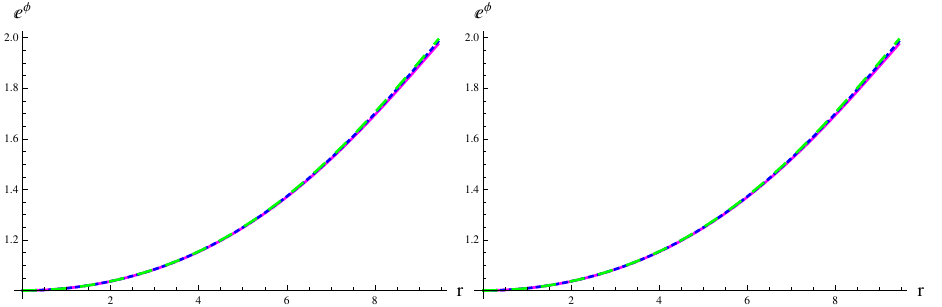
Figure 10. Plots of deformed radial metric components of anisotropic solution II for Υ = 0.2 ( left ) and Υ = 0.9 ( right ).